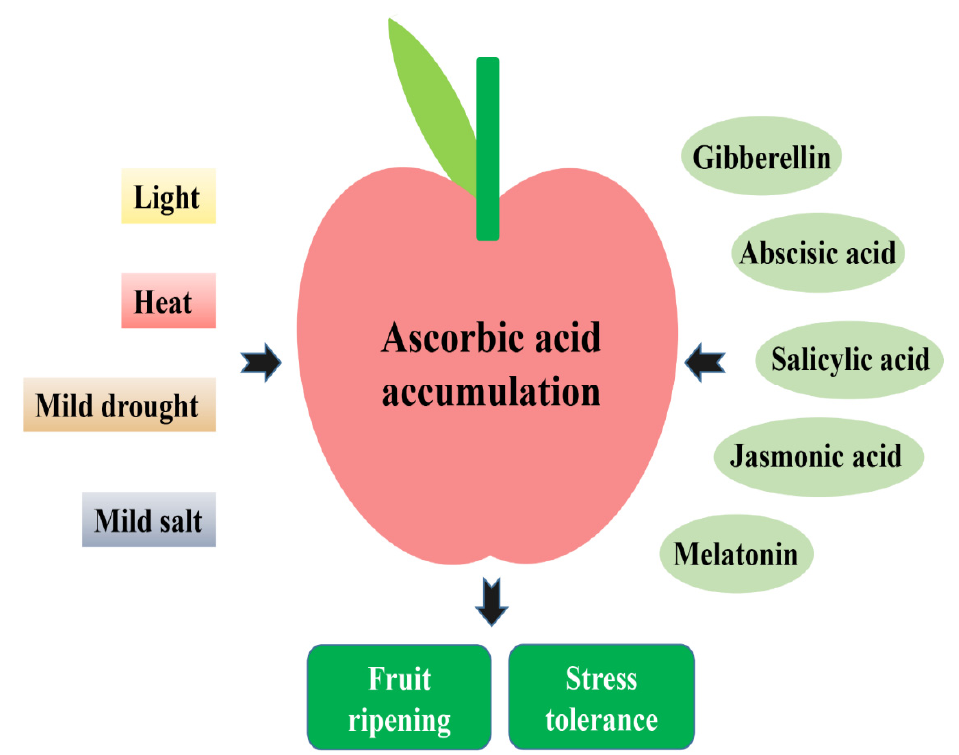
Figure 3. Effects of hormones and environmental factors on the accumulation of AsA in fruits. Light, heat, mild drought, and mild salt can stimulate the accumulation of ascorbic acid in the fruit. In addition, phytohormones, such as gibberellin, abscisic acid, salicylic acid, jasmonic acid, and melatonin, can also regulate the accumulation of ascorbic acid in fruits. These environmental factors and phytohormones affect fruit ripening and stress resistance by regulating the accumulation of ascorbic acid in fruits.